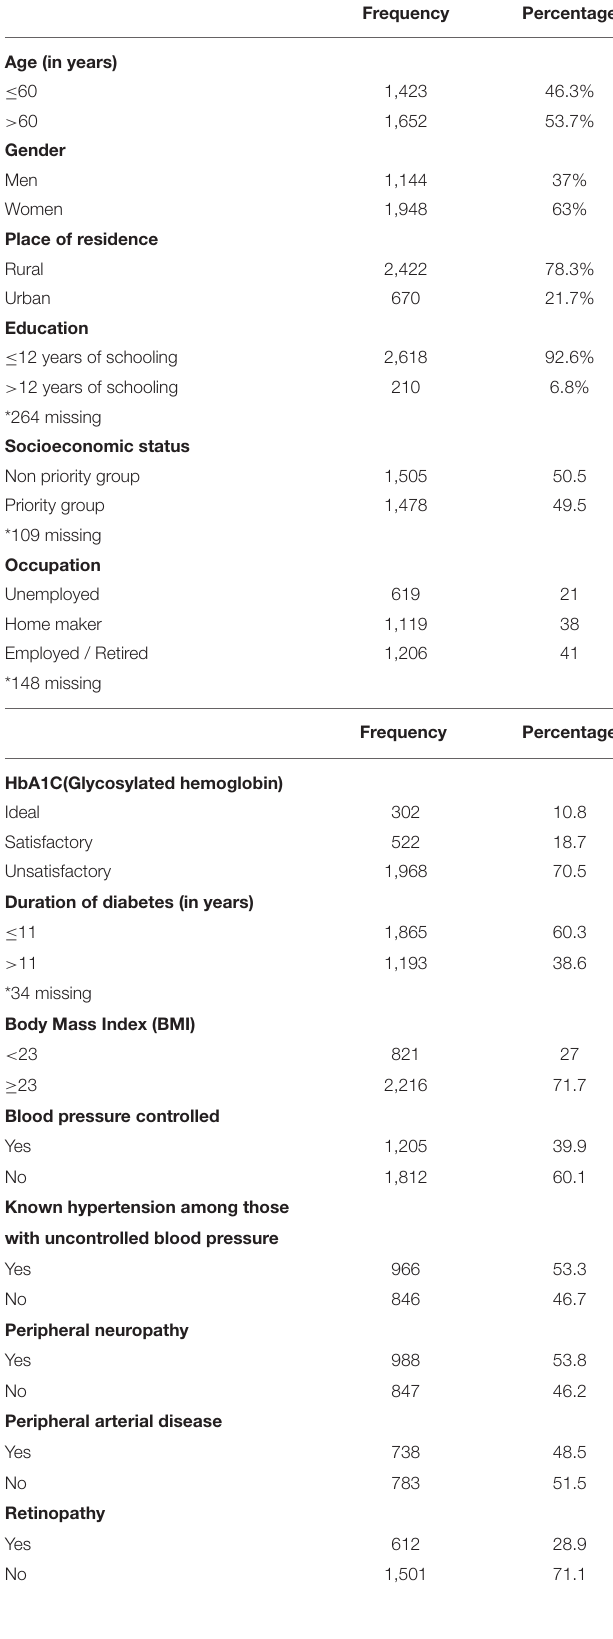
TABLE 1 | Sociodemographic distribution of the study